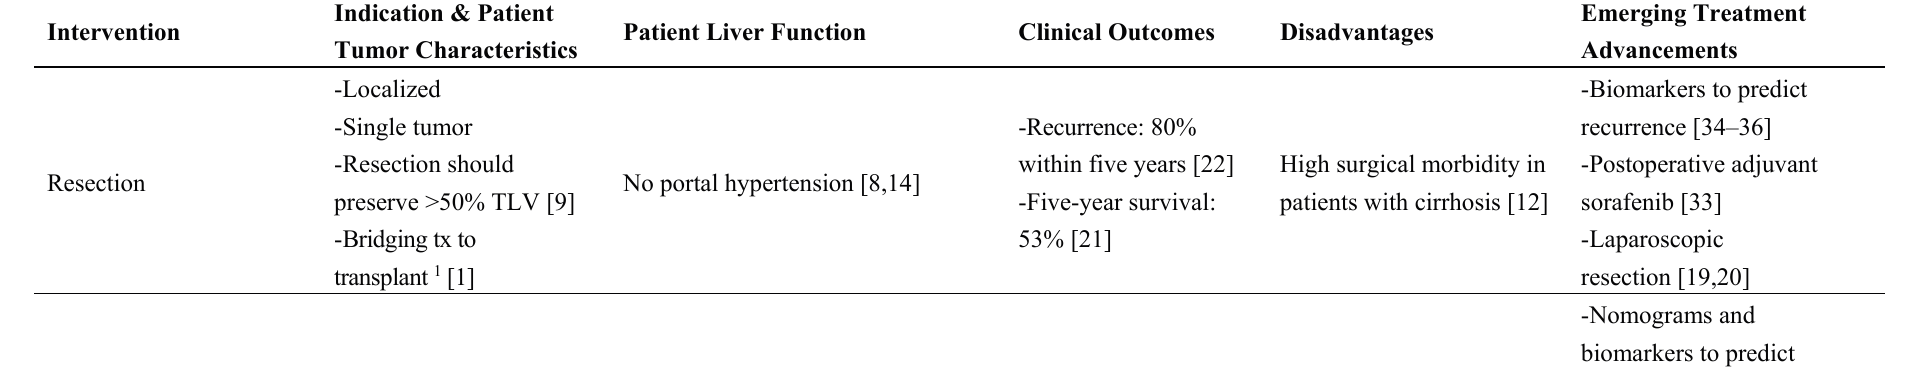
Table 1. Current treatment approaches for patients with